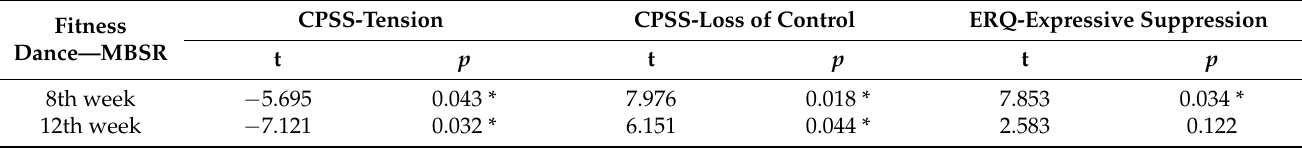
Table 4. The simple effect analysis of Time × Group of “Fitness